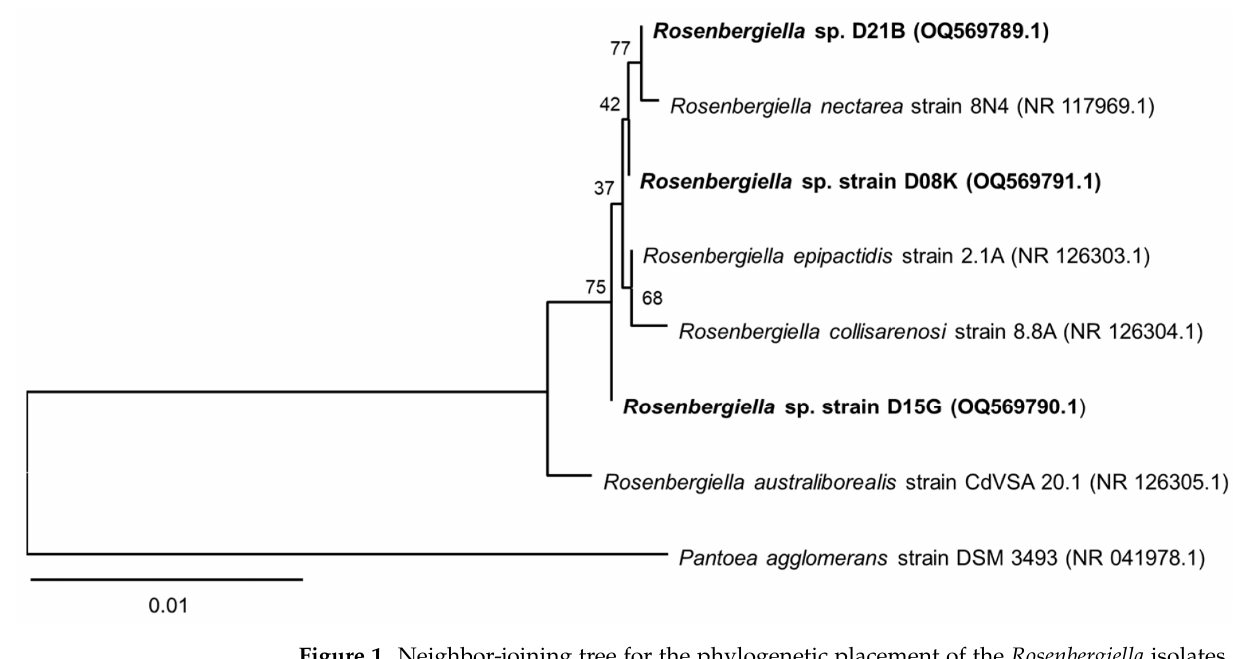
Figure 1. Neighbor-joining tree for the phylogenetic placement of the Rosenbergiella isolates from T. carbonaria based on 16 S rRNA gene sequences. R. meliponini D21B strain clusters together with